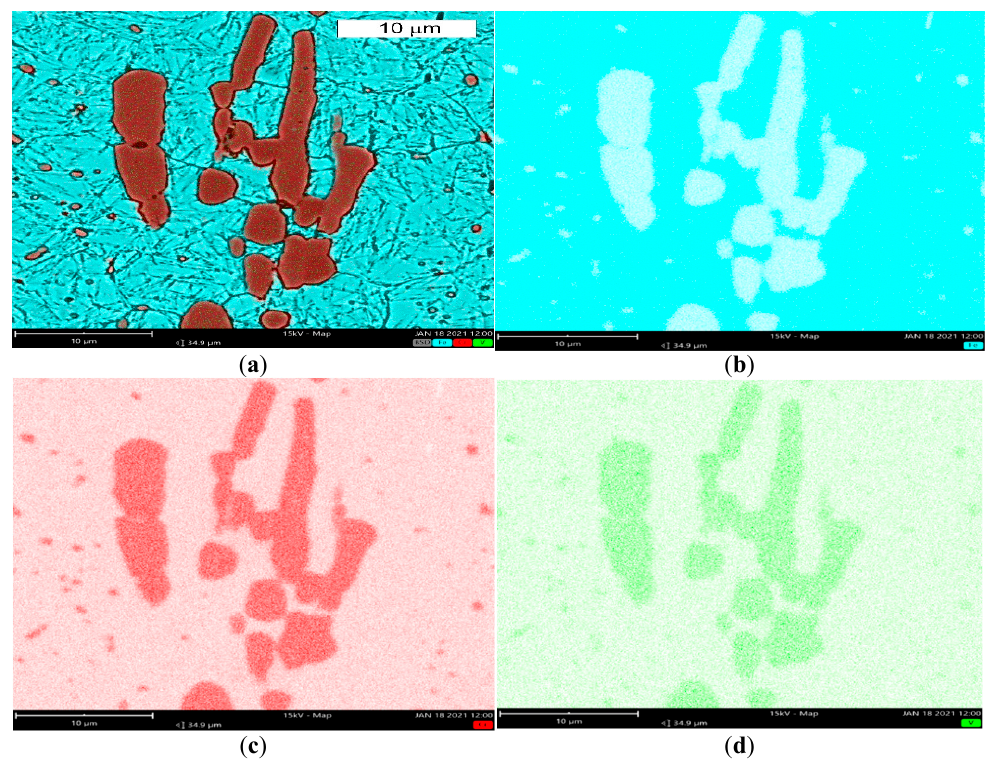
Figure 13. Element distribution in the microstructure area: ( a ) microscopic image with Fe, Cr and V distribution, ( b ) iron distribution, ( c ) chromium distribution, ( d ) vanadium distribution. SEM/EDX.